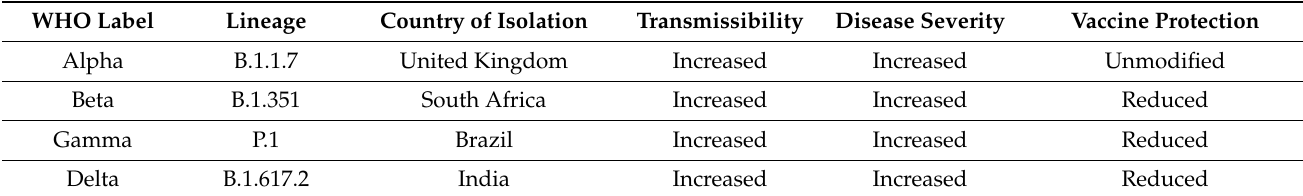
Table 5. SARS-CoV-2 variants of concern (from Ref. [64]